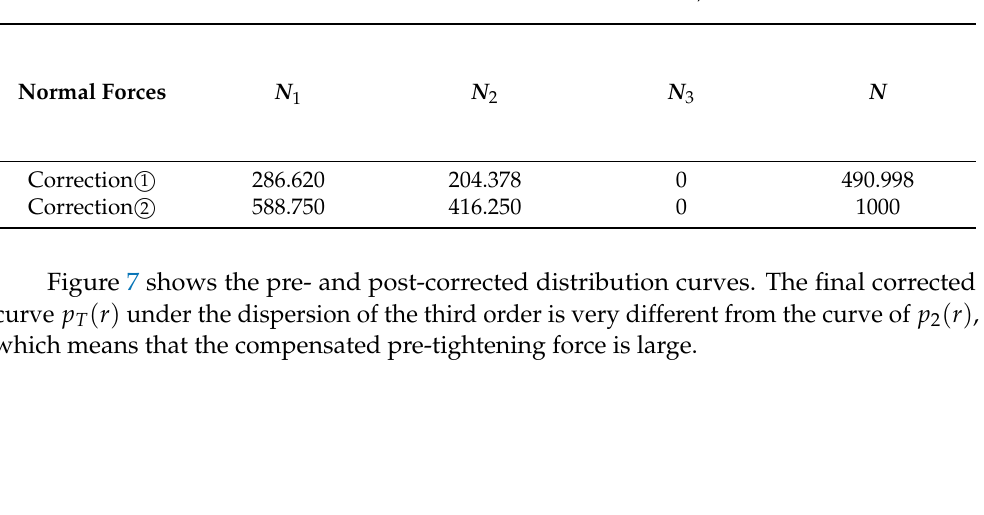
Table 3. Normal forces of discrete areas of translation method T = 0 N, n =